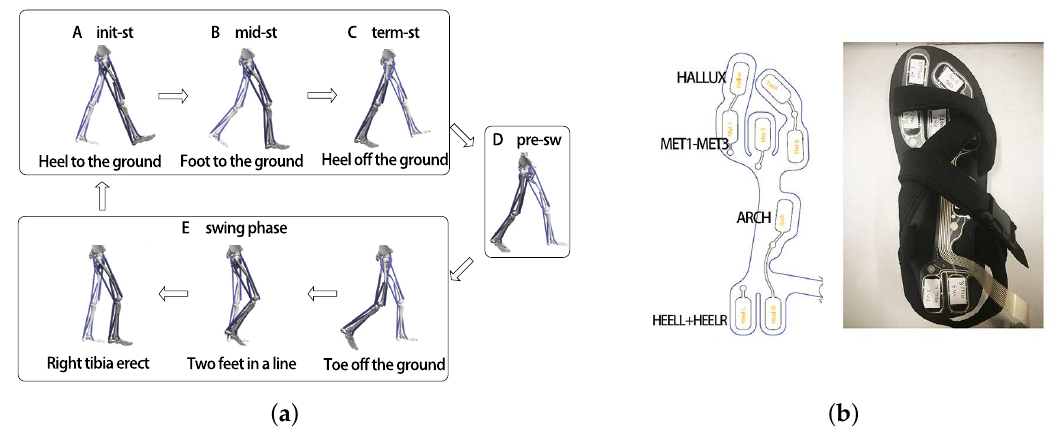
Figure 3. The left shows the division of seven gait phases, which represent the statistical results of the plantar pressure signal; the plantar pressure data is collected by the right High Dynamic Force Sensing Resistor-Insole. ( a ) Gait division; ( b )High Dynamic Force Sensing